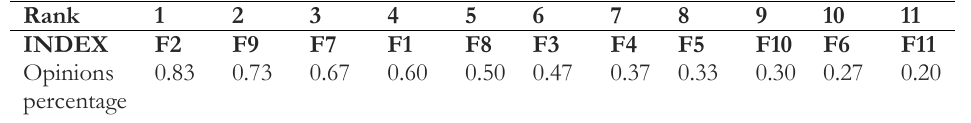
Table 8. Arrangement of index in order to